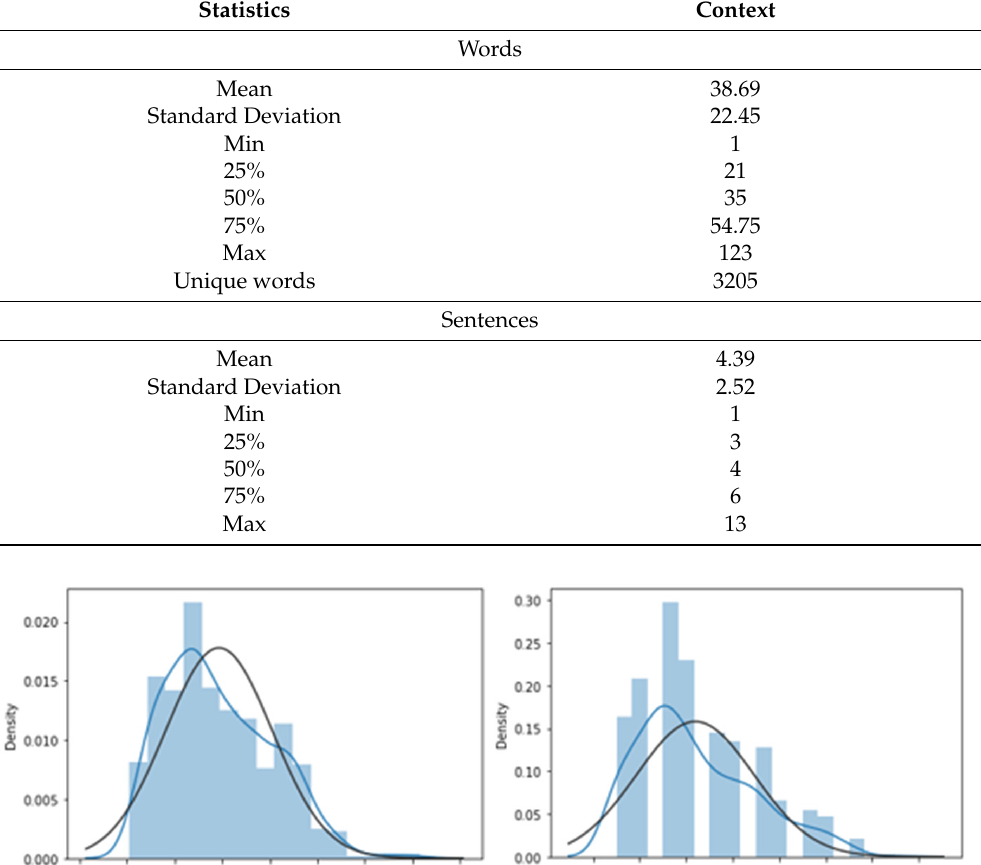
Table 1. General statistics of the context field.